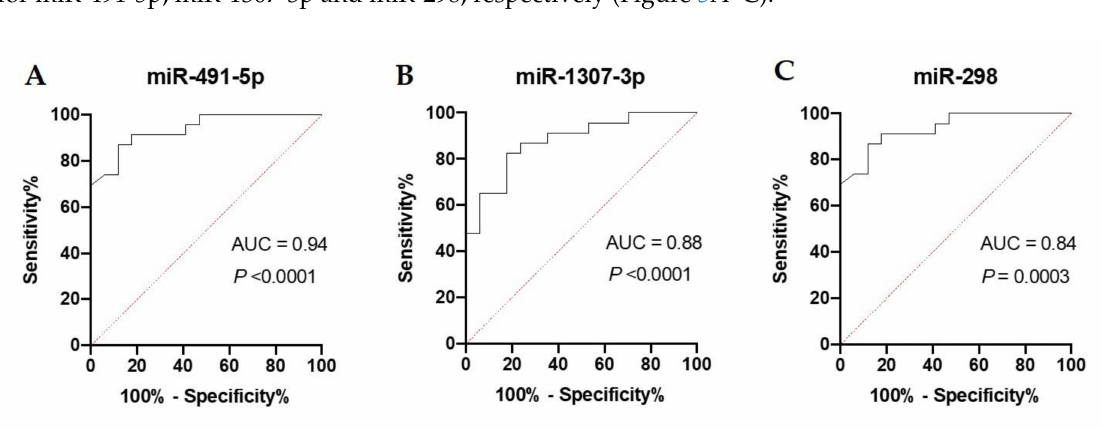
Figure 5. ROC analysis was constructed to evaluate the diagnostic values of the selected miRNAs as predictive biomarkers of type 2 diabetes: ( A ) miR-491-5p; ( B ) miR-1307-3p; ( C ) miR-298.